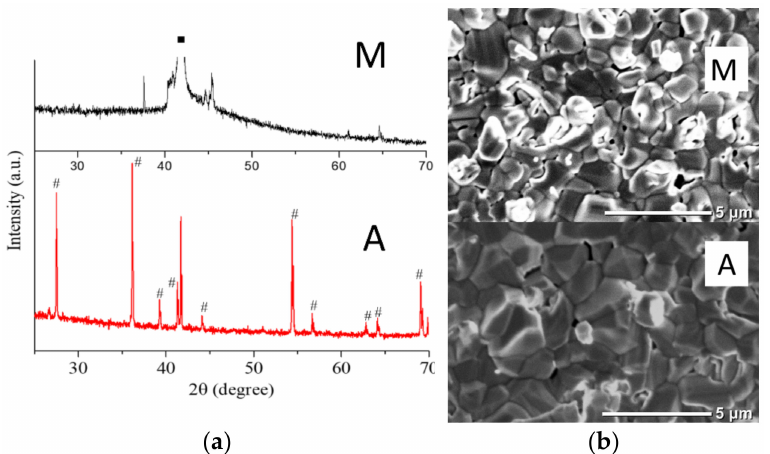
Figure 7. X-ray diffraction patterns ( a ) and SEM images of the surface ( b ) of samples of titanium oxides of types M and A. Designations: (cid:4) —reflections of a sapphire substrate; #—reflections of titanium dioxide (rutile). Card number